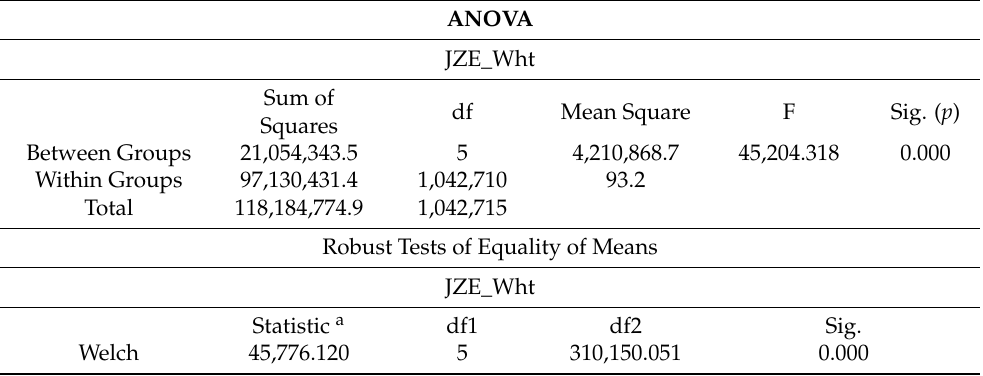
Table 5. The results of ANOVA test.